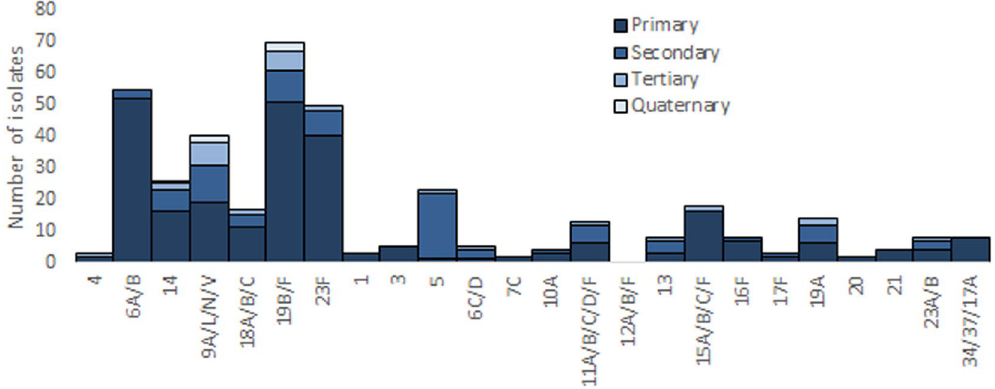
Figure 4. Serotype/group specific ranking of multiple pneumococcal carriage. Each isolate of S. pneumoniae was ranked according to its carriage density as determined by quantitative PCR (qPCR) to other isolates present in the same sample. Single colonizers were included in the analysis as primary colonizing